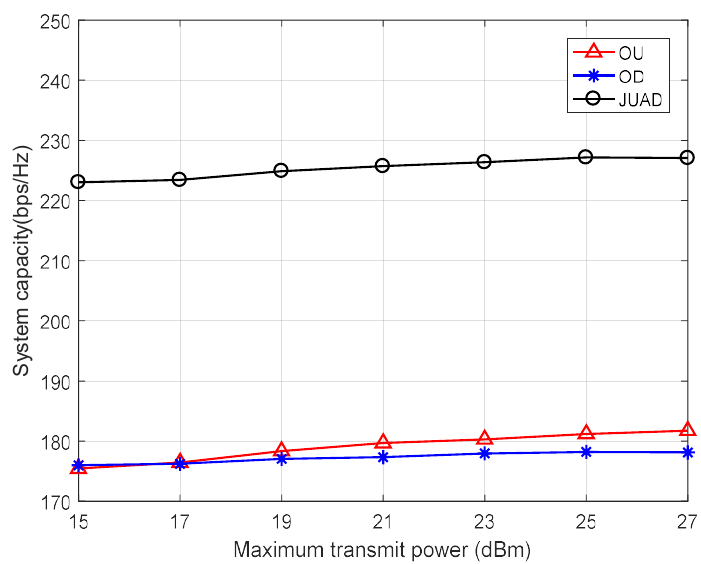
Figure 3. The system capacity with varying maximum transmission power, comparison of the joint uplink and downlink (JUAD)/only reuse uplink (OU)/only reuse downlink (OD) resource allocation schemes.